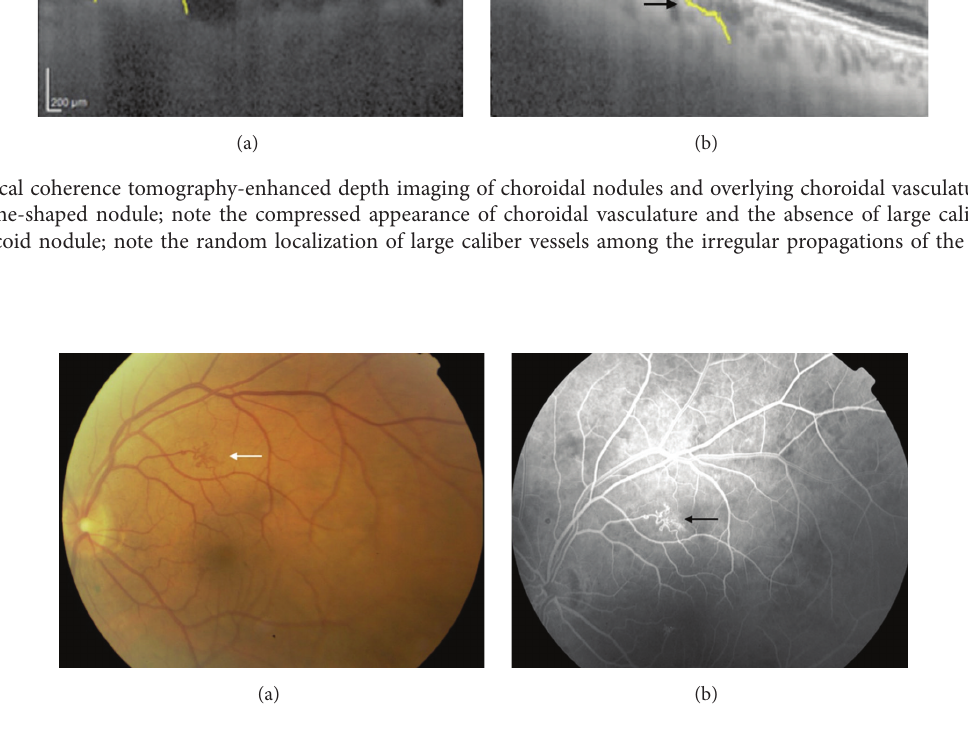
Figure 7: Retinal microvascular abnormality with “hemangioma-like” or “ball of thread” appearance in NF1. The retinal microvascular abnormality is shown with an arrow on the (a) fundus photograph and on the (b) fluorescein angiography image (modified from